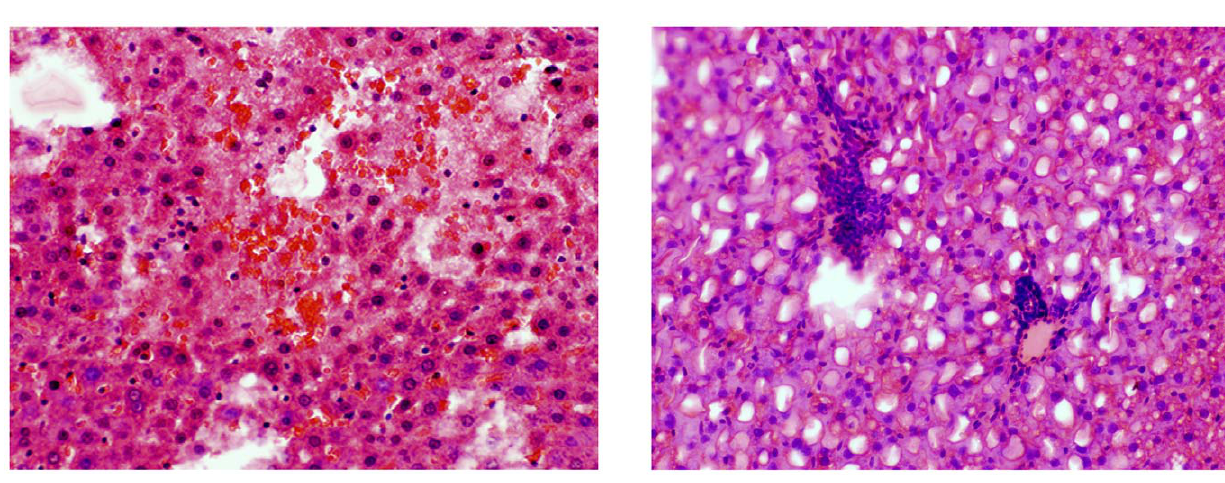
Figure 9. Liver injury group 2BP. Parenchymal inflammatory infiltration in steatotic areas from an animal in group 2BP.